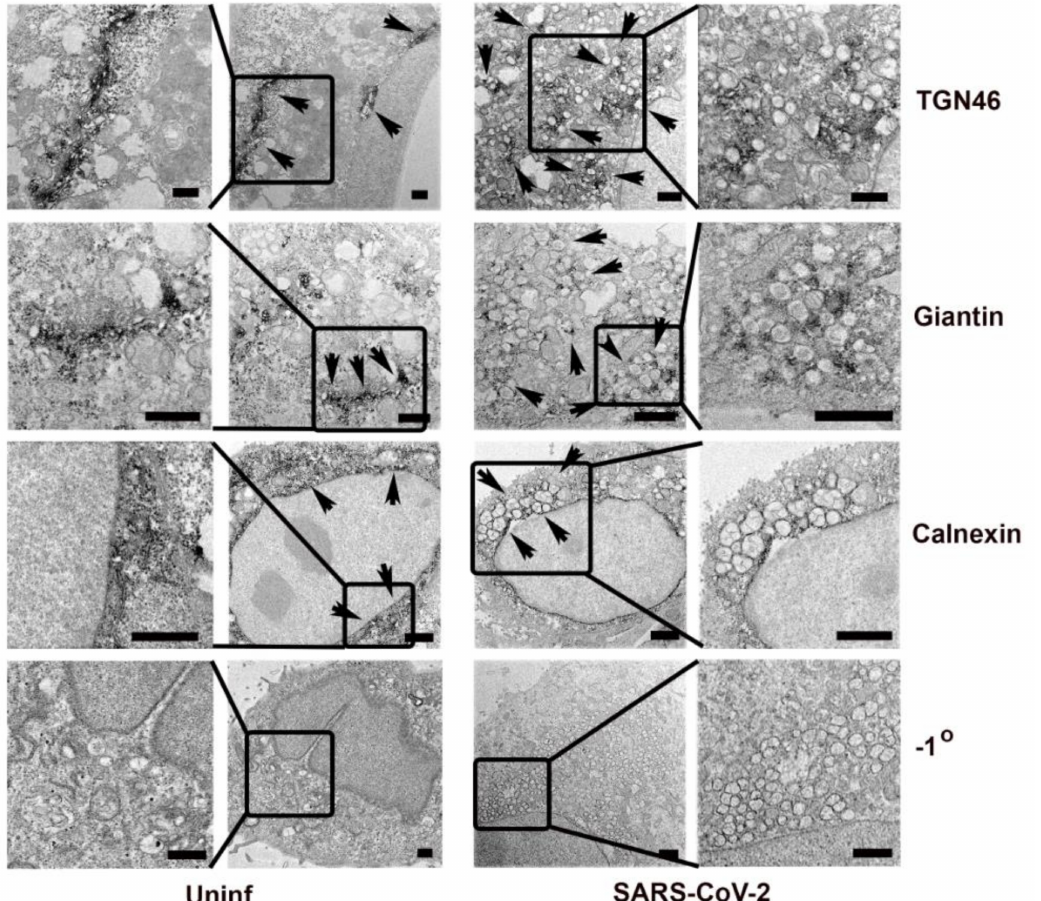
Figure 8. Immunoelectron microscopy localization of cellular antigens in Vero E6 cells fixed at 24 h post-infection for HRP-DAB staining. Dark reaction product indicates localization of the antigen. Shown are the Golgi specific markers TGN46 and giantin, as well as the ER marker calnexin. A panel showing negative staining in the absence of the primary antibody is shown ( − 1 ◦ ). Arrowheads indicate regions showing HRP-DAB labeling. Delineated regions of interest in the uninfected and infected cells are enlarged in the leftmost and rightmost columns, respectively, to show detail. Bars = 1 µ